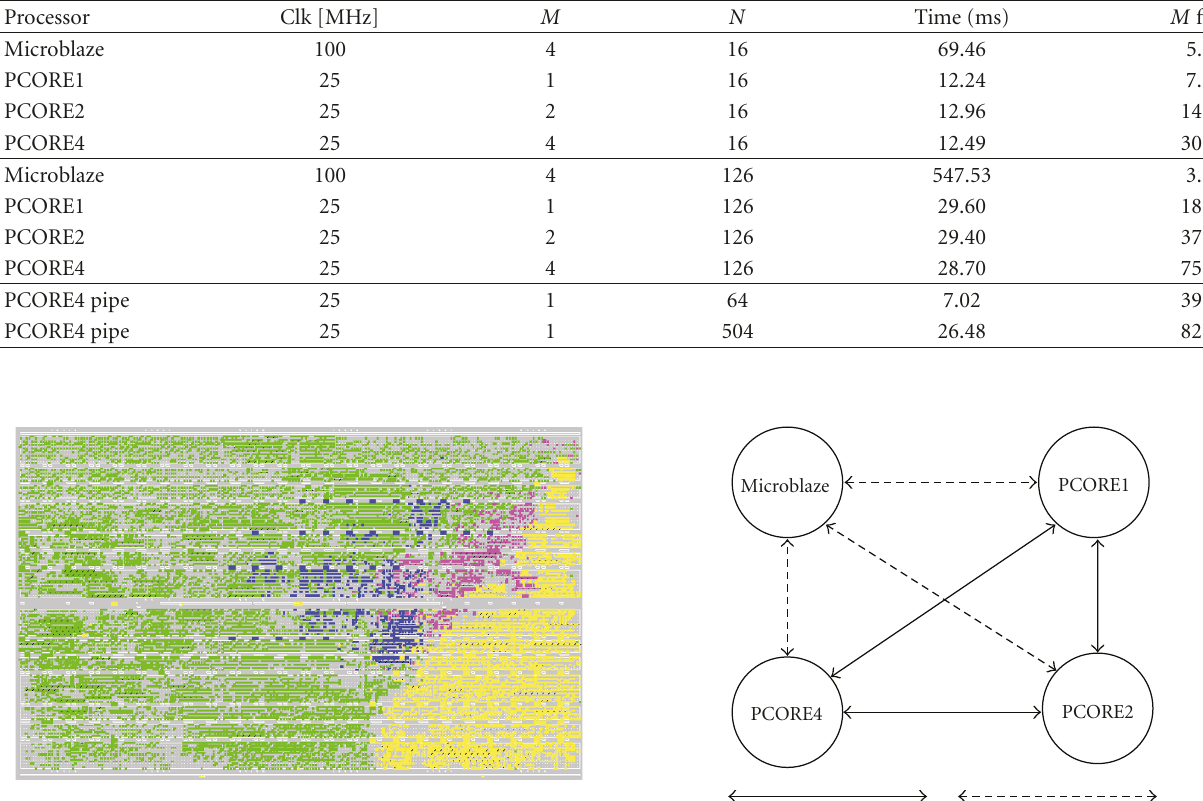
Figure 7: Floor-plan of the RLS lattice filter implementa- tion: Microblaze processor (yellow), FSL communication interface (blue), batch processing control (in purple) and the RLS lattice core (green); the Xilinx Virtex4 SX35 usage is 78%. Figure 8: Reconfiguration states with switch possibilities.